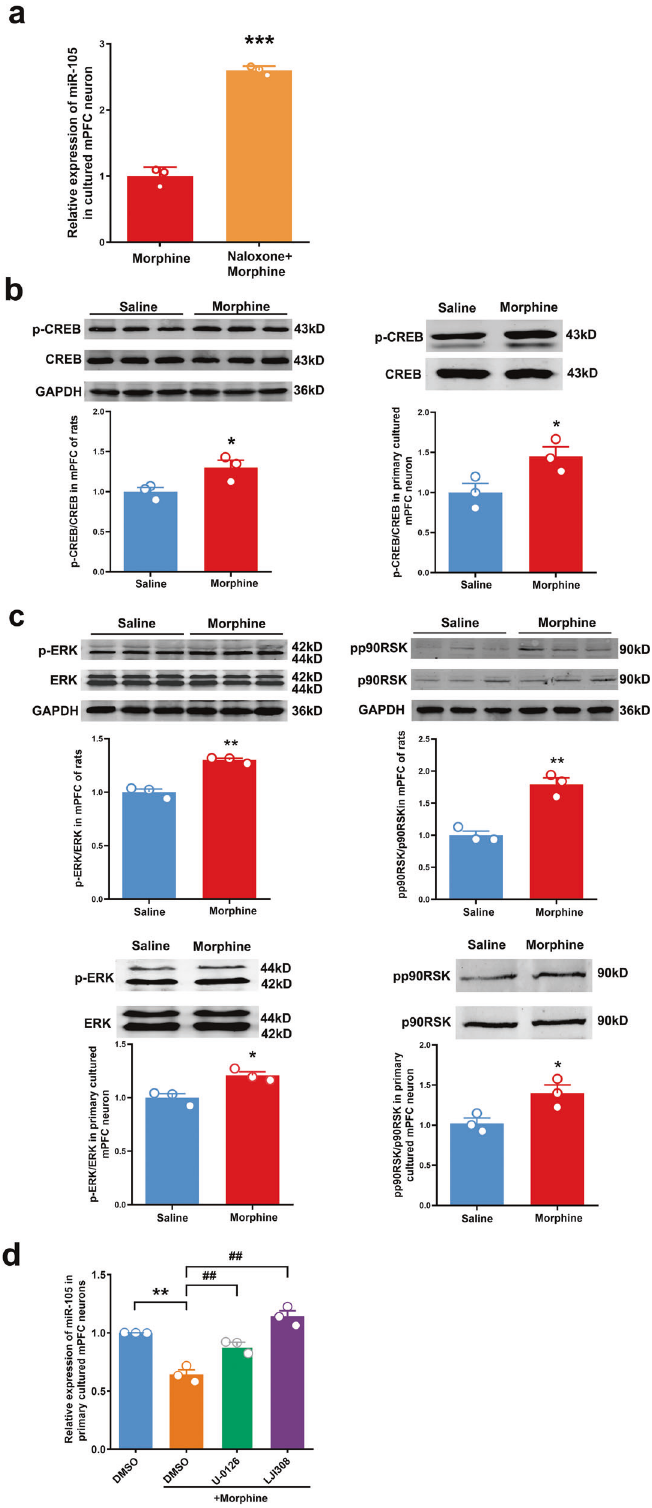
Fig. 2 The in fl uence of chronic morphine on the signaling molecules of CREB, ERK, and p90RSK in rat mPFC. a The in fl uence of naloxone on the miR-105 expression in primary cultured mPFC neuron treated by morphine ( n = 3 in each group, unpaired two-tailed Student ’ s t -test, *** P < 0.0001). b The expressions of p-CREB to total CREB in rat mPFC (left panel) and primary cultured mPFC neurons (right panel) ( n = 3 in each group, unpaired two-tailed Student ’ s t -test, * P < 0.05, ** P < 0.01). c The expressions of p-ERK/ERK and pp90RSK/p90RSK in rat mPFC and primary cultured mPFC neurons ( n = 3 in each group, two-tailed Student ’ s t -test, * P < 0.05). d The expression of miR-105 in primary cultured mPFC neurons of DMSO group, DMSO + morphine group; U0126 + morphine group and LJI308 + morphine group ( n = 3 in each group, one- way ANOVA, F (3,8) = 37.40, P < 0.0001. Bonferroni post hoc: ** P = 0.0005, DMSO vs DMSO + Morphine, ## P = 0.006 and 0.000, Morphine + U0126 and Morphine + LJI308 vs Morphine group, respectively). Data are presented as mean ±